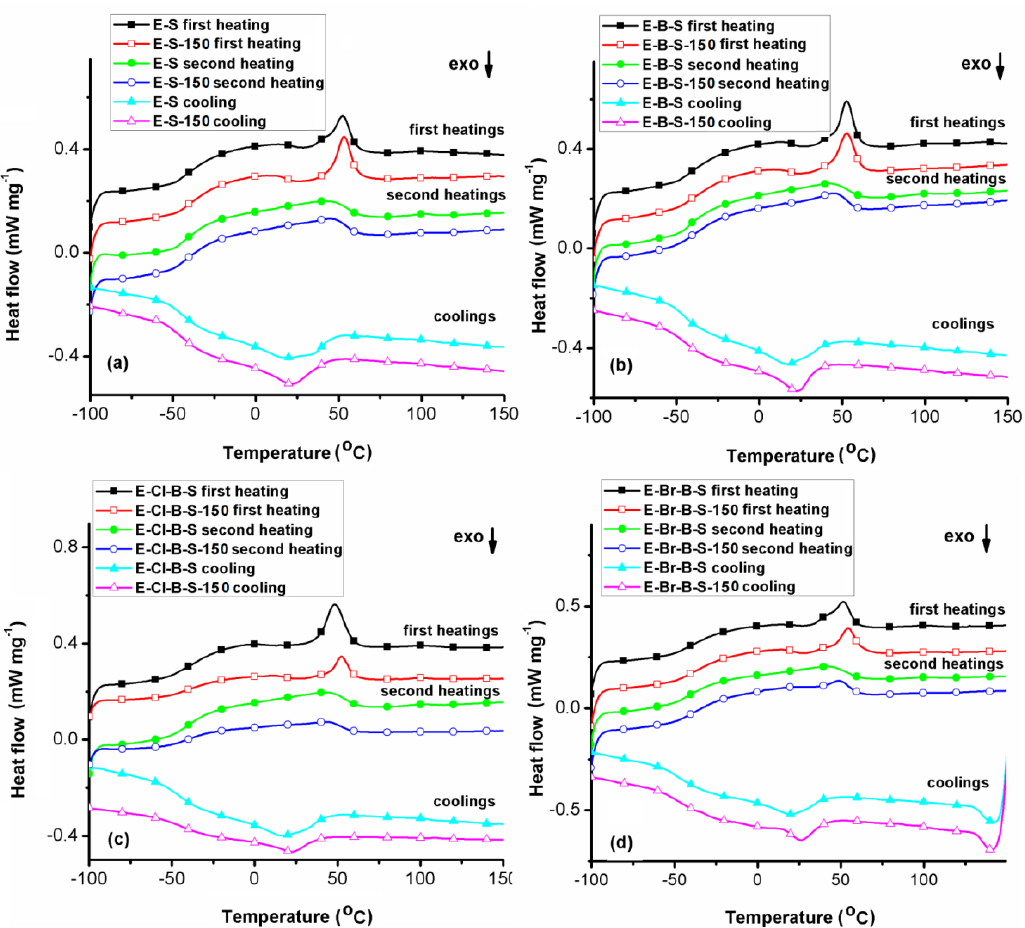
Figure 11. Differential scanning calorimetry (DSC) curves of initial and irradiated at 150 kGy samples: ( a ) E-S, ( b ) E-B-S, ( c ) E-Cl-B-S, ( d ) E-Br-B-S. Table 3. Data extracted from the DSC curves of the EPDM rubber composites.